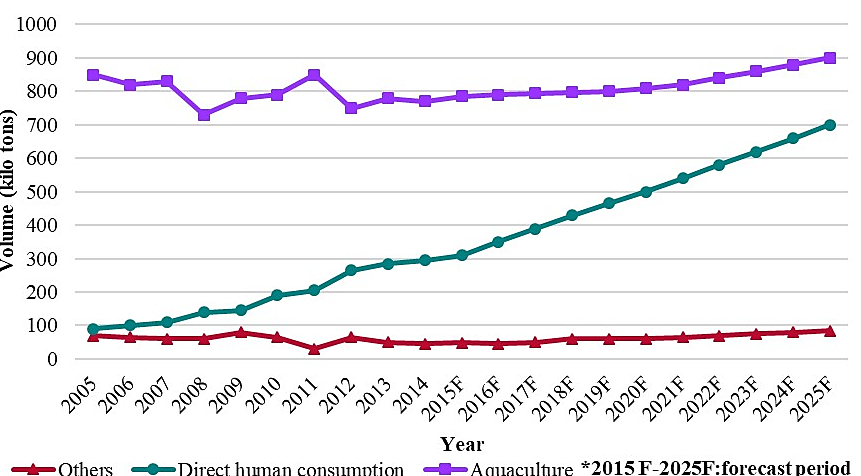
Fig. 1. Global consumption of fish oil